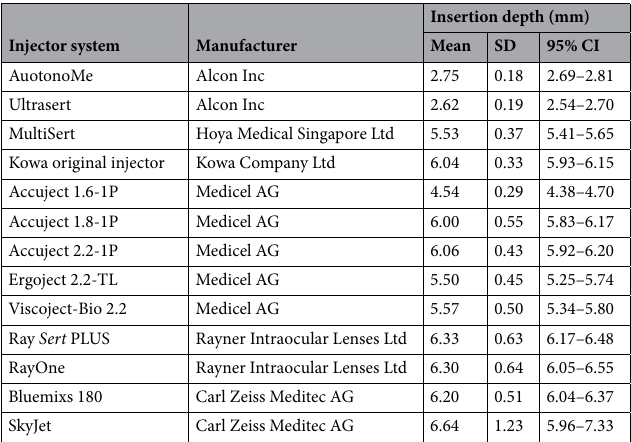
Table 2. Insertion depth of intraocular lens injector systems into a clear corneal incision.